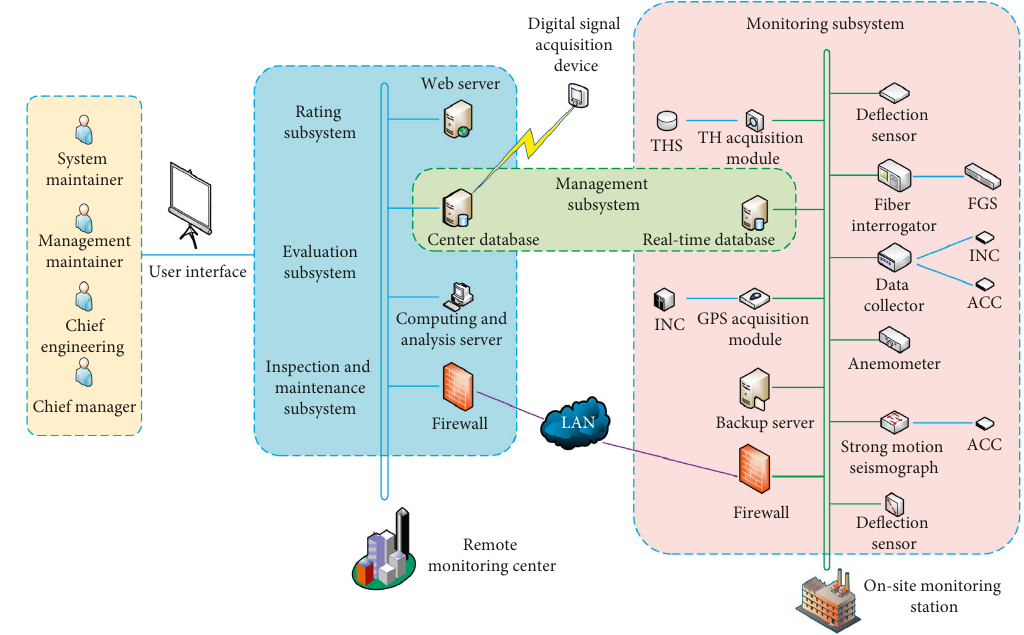
Figure 5: Overall framework of the monitoring